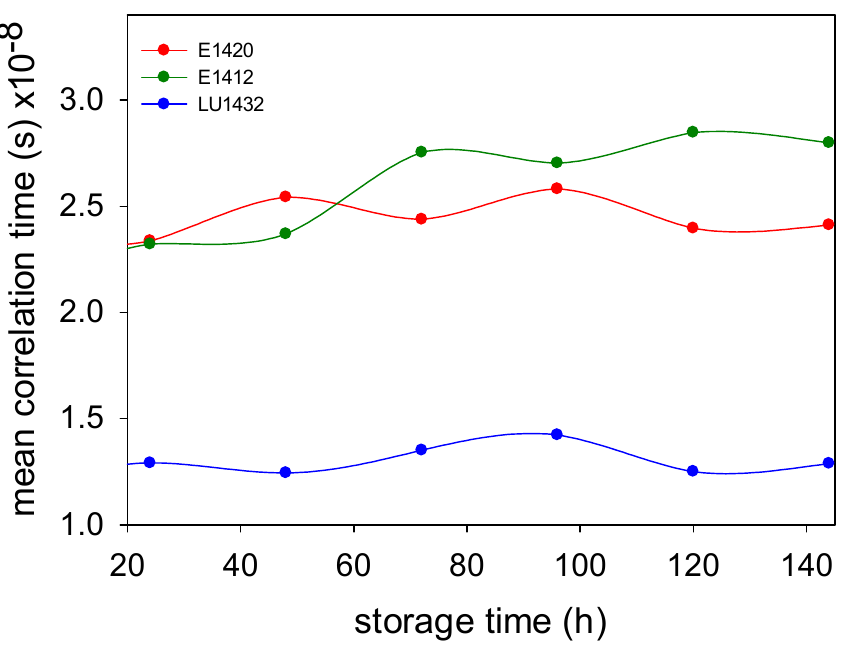
Figure 6. Time-dependent changes in mean values of proton motion correlation times of starch proton fraction in porcine fat emulsions emulsified with potato starches. The use of LU 1432 starch as an emulsifier made the starch fraction of protons in the porcine fat emulsion stable in time. The mean values of proton motion correlation times are the smallest, which reflects the weakest binding of water compared to the other ana- lyzed starches. The emulsions with E 1420 starch are also time-stable, but in this system, the correlation times are much longer compared to the LU 1432 starch-stabilized emul- sions. This means that E 1420 starch is an emulsifier that inhibits molecular movements of protons in the starch fraction of the emulsion. The best water binding, already after about 3 days of storage, was found when using starch E 1412 as an emulsifier in porcine fat emulsions.